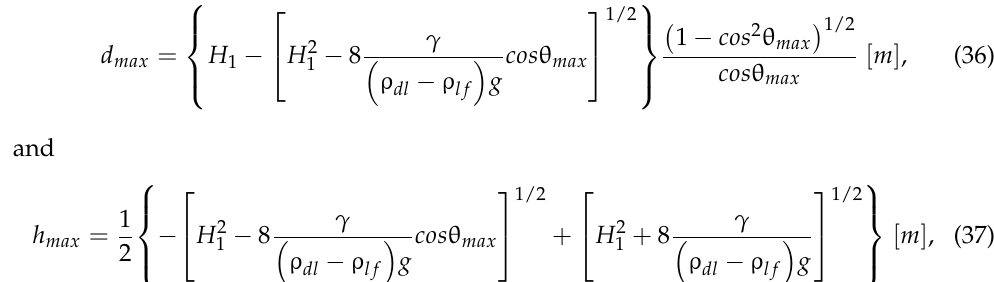
Figure 6. A pendant drop ( a ) at gauge pressure of H 1 lower than H 1 min , and not fully created bubble ( b ) at negative gauge pressure of H 2 higher than H 2 max .